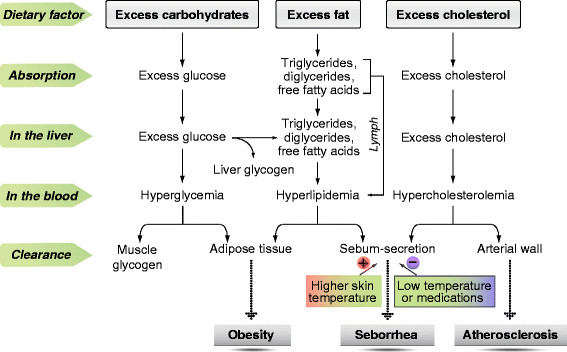
Relationships among excess energy intake, skin function and health outcomes. +, stimulation; –, inhibition.